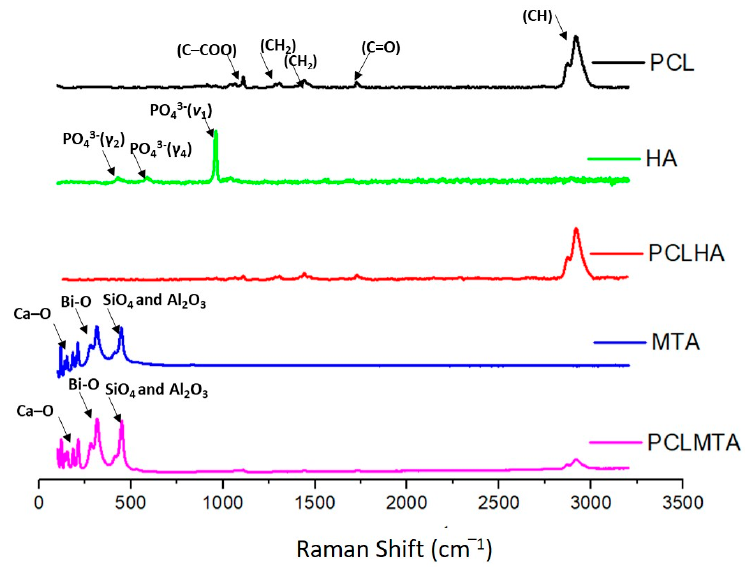
Figure 4. Raman spectroscopic analysis of PCL, HA, PCLHA, MTA, and PCLMTA. The respective Raman shift value of each material is represented by arrows.